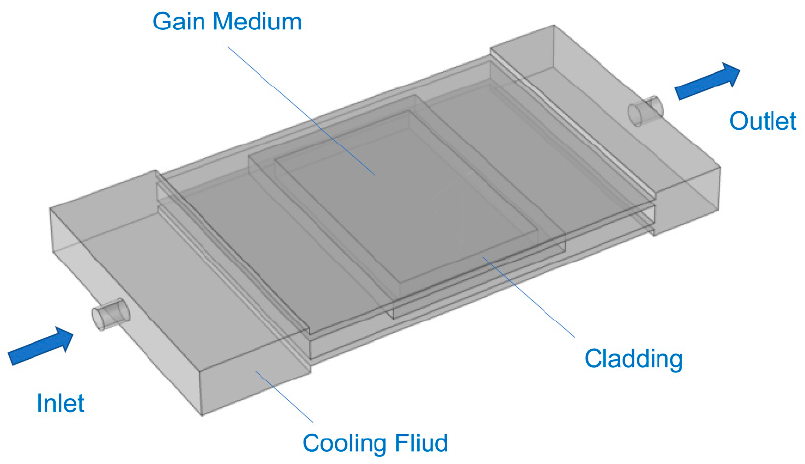
Figure 7. Diagram of the thermal-fluid-solid multiphysics model. The temperature and stress distribution of Nd:LuAG in central plane were calculated, which is shown in Figure 8. The temperature difference in the central plane is 3.7 K, which is acceptable in a laser amplifier. The maximum stress in the gain medium is 1.4 MPa, which is far lower than the breaking stress of